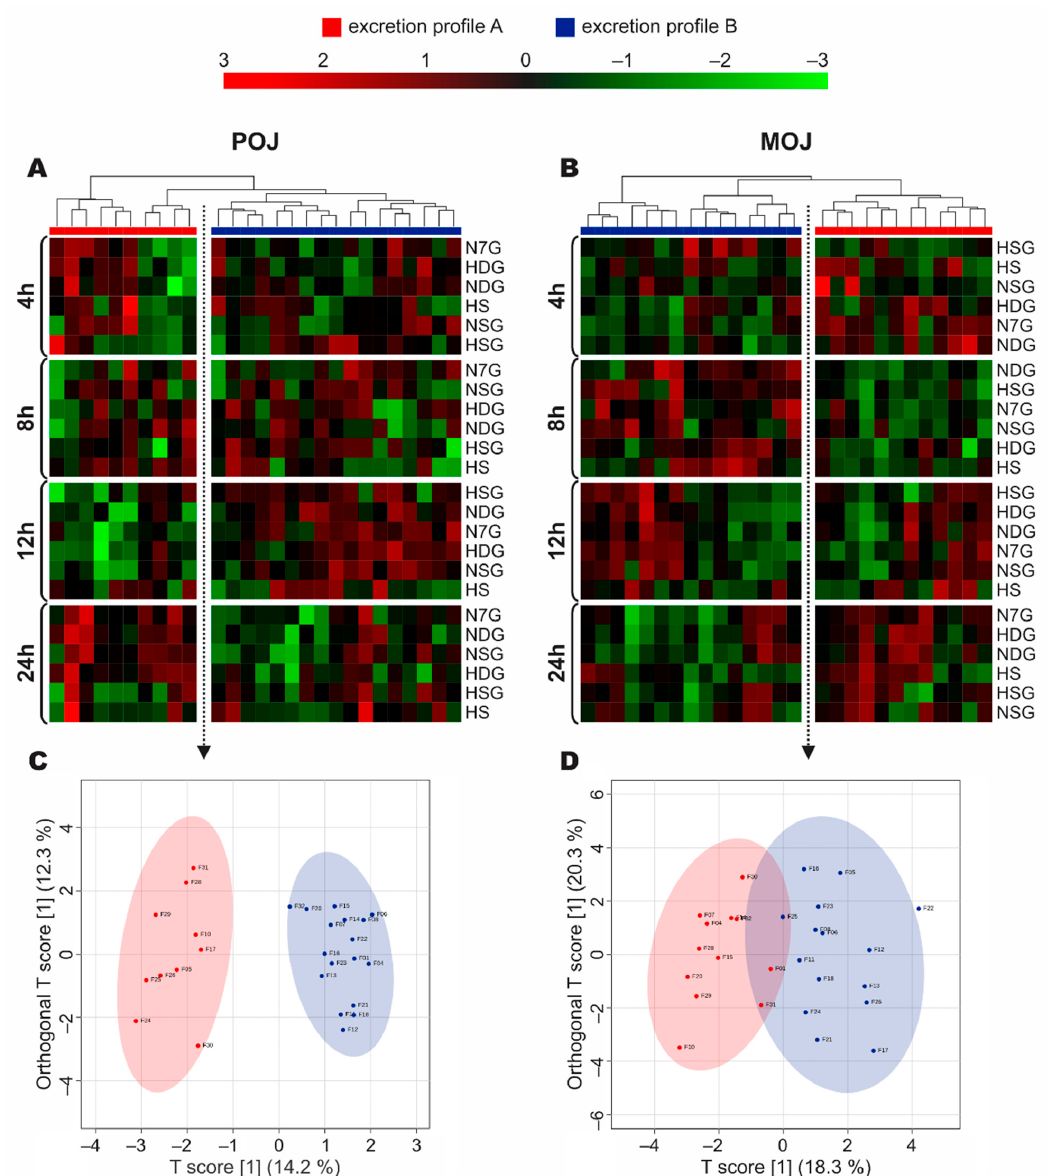
Figure 3. Heatmap of phase II flavanone metabolites excreted in urine over a 24 h period (four collected intervals) after the intake of Pera (POJ) and Moro (MOJ) orange juices (( A , B ), respectively), separated into Excretion Profiles A and B. The oPLS-DA data show the Excretion Profiles according to phase II metabolite excretion in urine over the 24 h period (( C , D ), respectively) (n of POJ = 10 volunteers with Profile A and 17 with Profile B; n of MOJ = 12 volunteers with Profile A and 15 with Profile B).